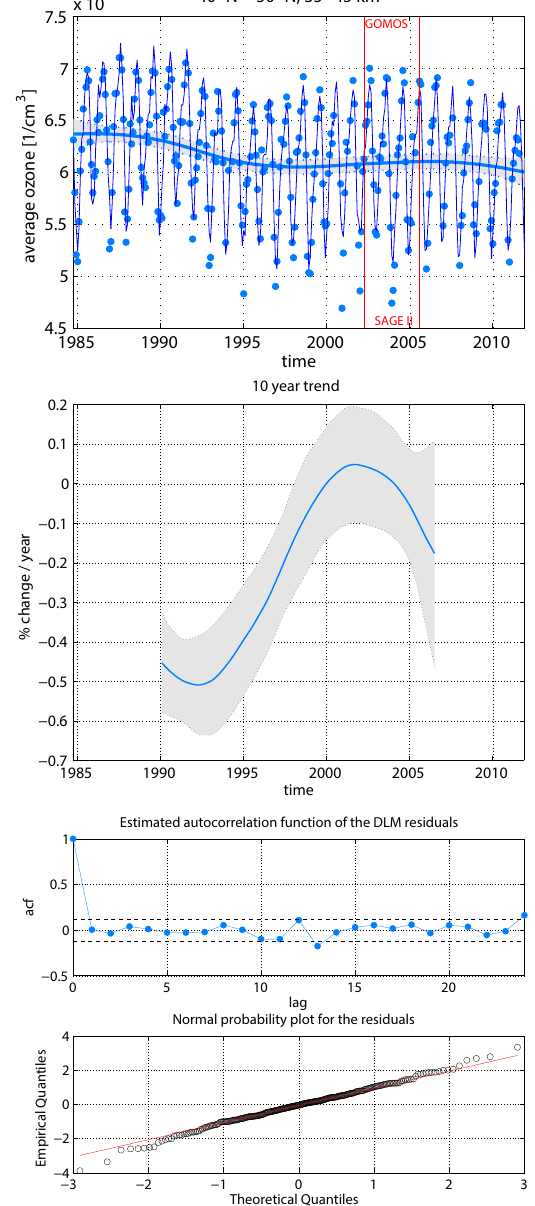
−3 Figure 2. DLM fit for average ozone at 40–50 ◦ N, 35–45km. In the upper panel the dots are the observations used in the analysis, the solid line following the observations is the DLM fit obtained by a Kalman filter. The smooth solid line is the background level compo- nent of the model with 95% probability envelope. The beginning of GOMOS observations as well as the end of SAGE II are shown by red vertical lines. In the lower left panel an analysis of the 10-year trend is performed, showing the mean estimated trend and its 95% probability envelope. The lower right panel shows model diagnos- tic analyses on the residuals by an estimated autocorrelation func- tion (ACF) and by a normal probability plot. In the autocorrelation function plot, dashed horizontal lines correspond to the approxima- tive region where the coefficients do not significantly (95%) deviate from zero. The unit of lag is